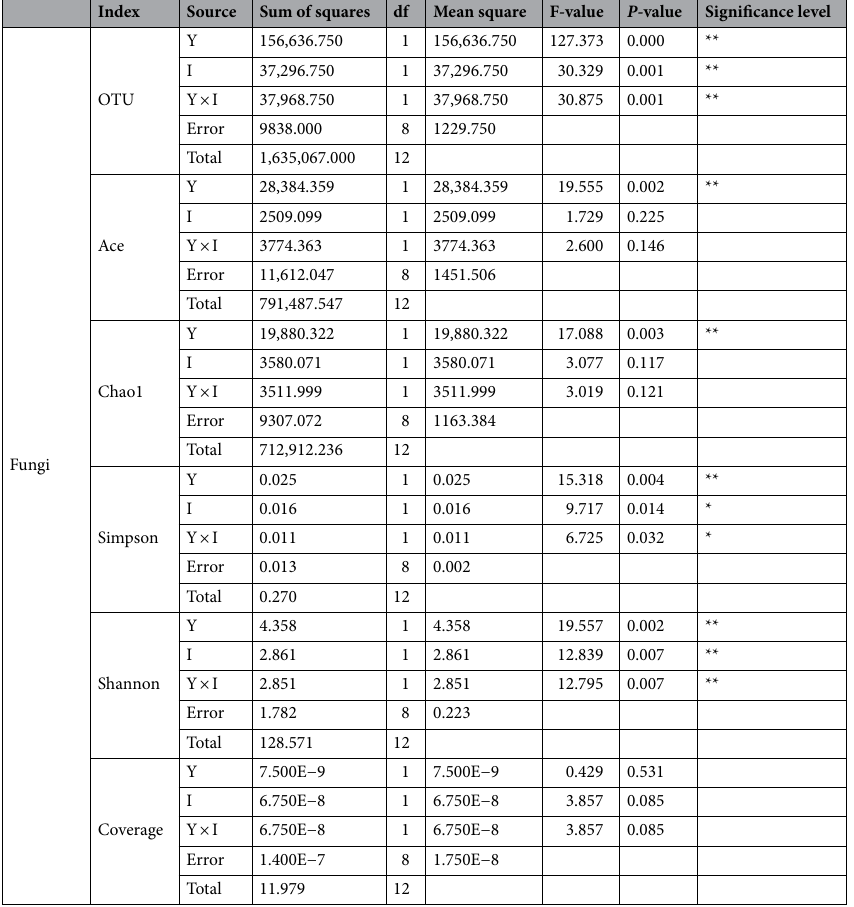
Table 5. Variance analysis of the factorial design of diversity indices of bacteria and fungi in different samples. Y represents continuous cropping regimes. I represents inoculated with R. intraradices . *Factors are significant at P < 0.05 level. **Factors are significant at P < 0.01